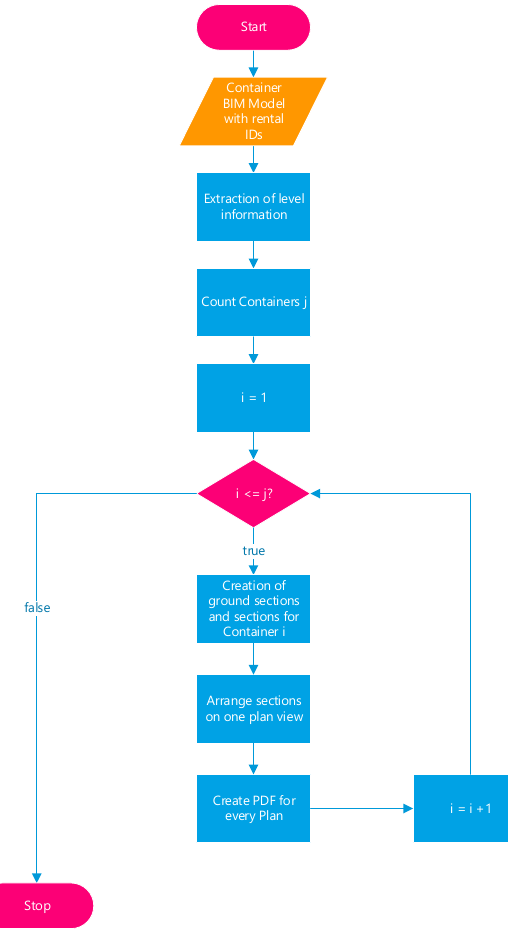
Figure 12. Create 2D plans algorithm.